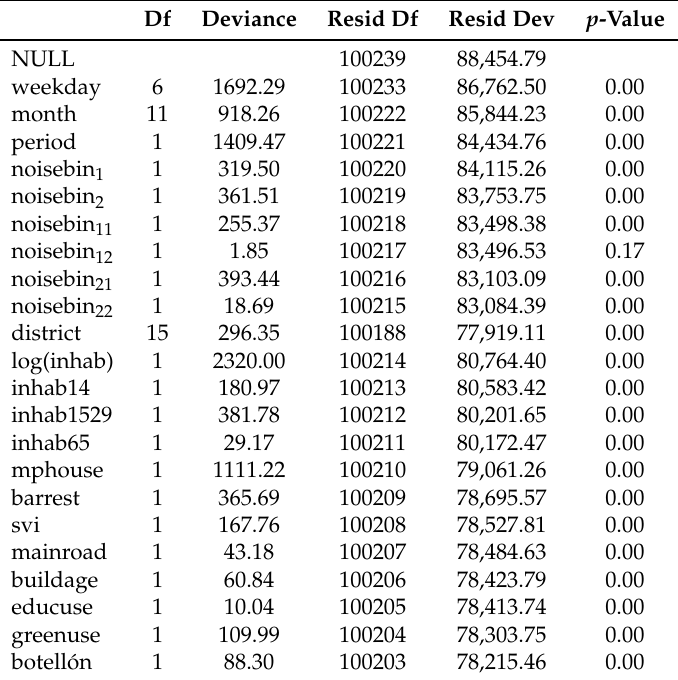
Table 2. Model deviance